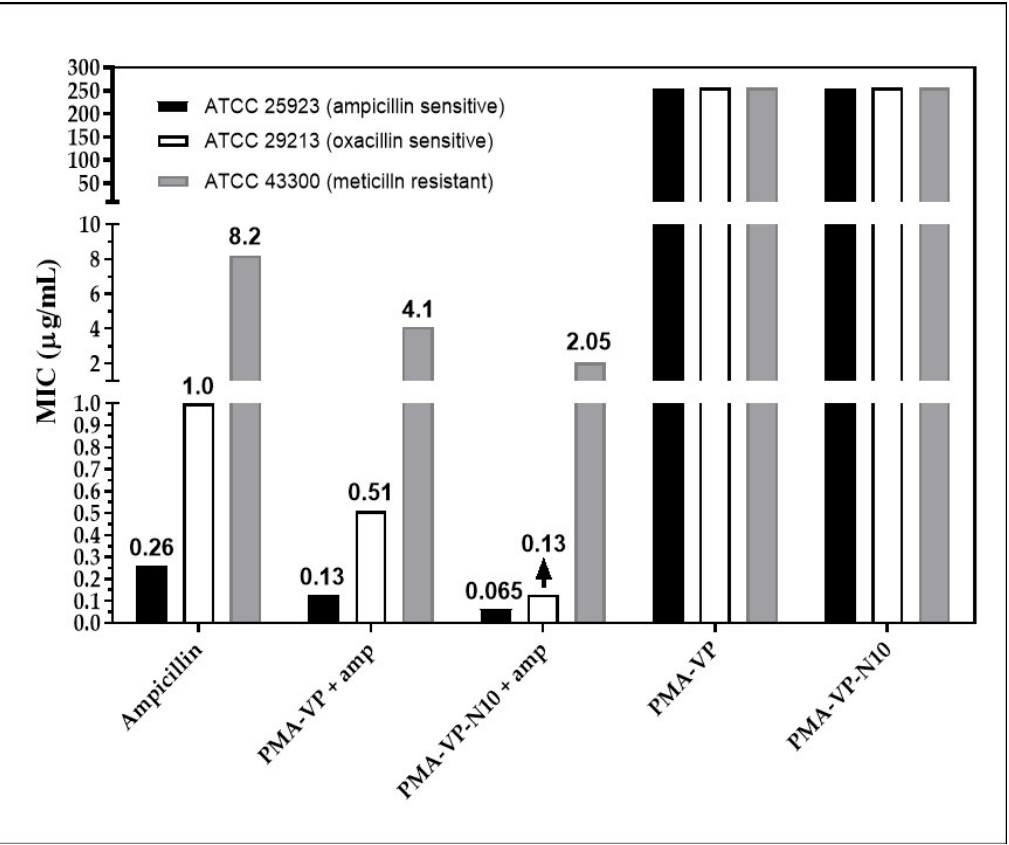
Figure 6. Minimum inhibitory concentration for ampicillin-PMA-VP and ampicillin-PMA-VP-10Na nanoparticles.